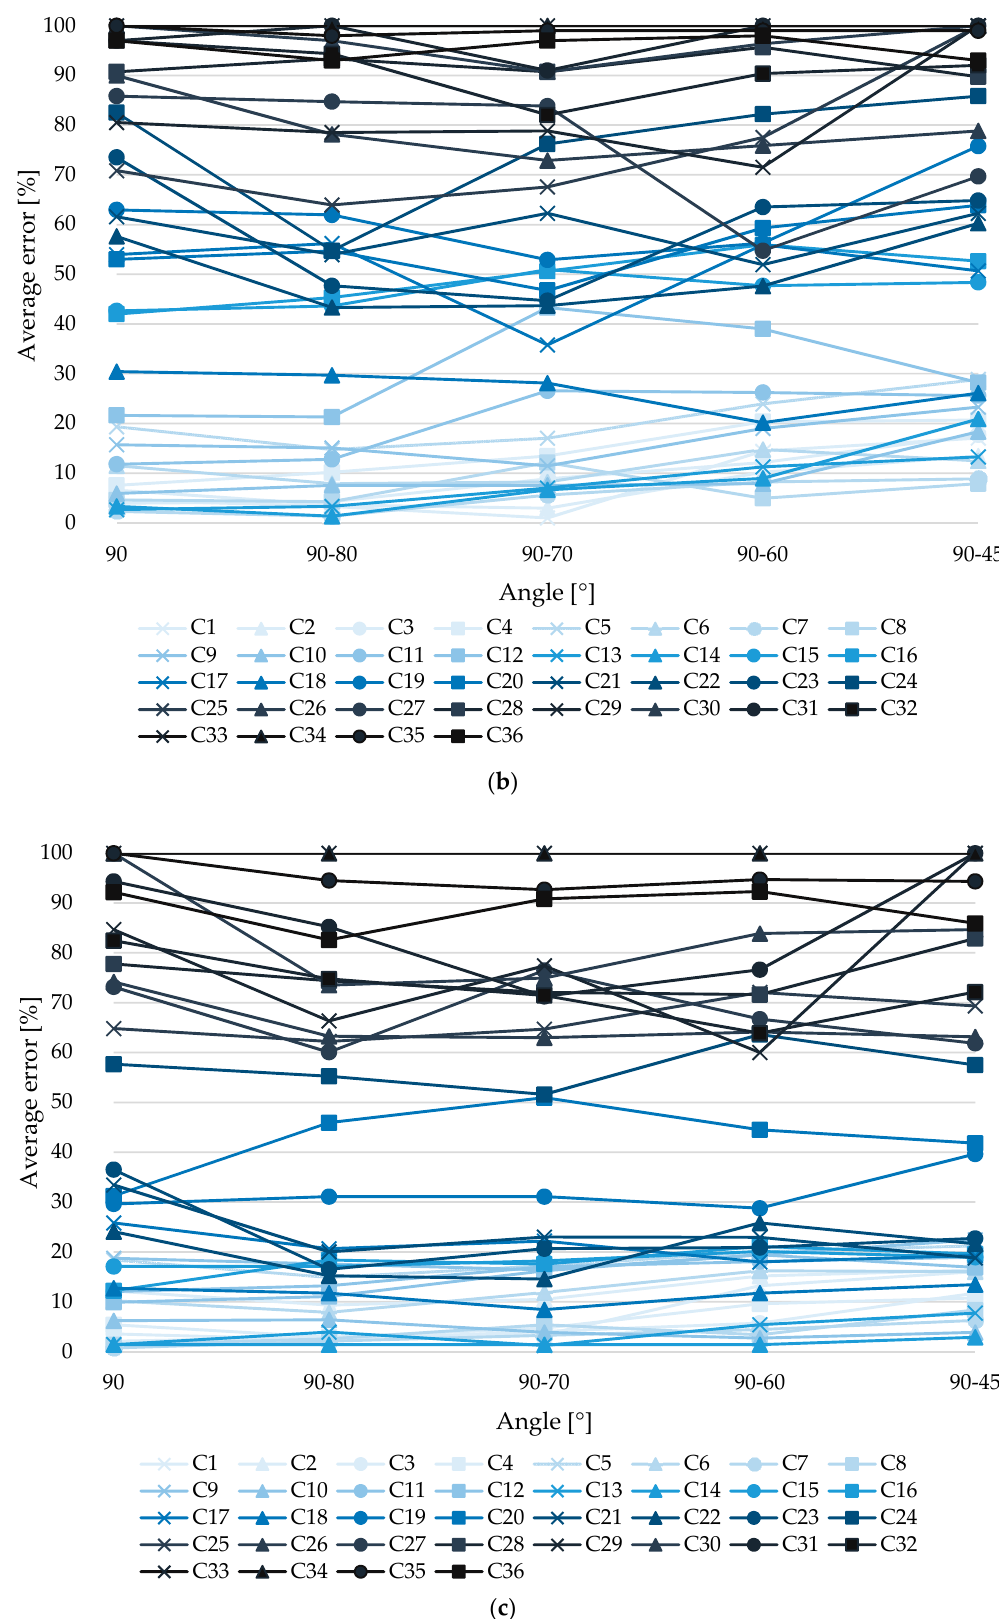
Figure 5. Average relative depth error behavior for different severity levels. ( a ) low severity; ( b ) mean severity; ( c ) high severity.